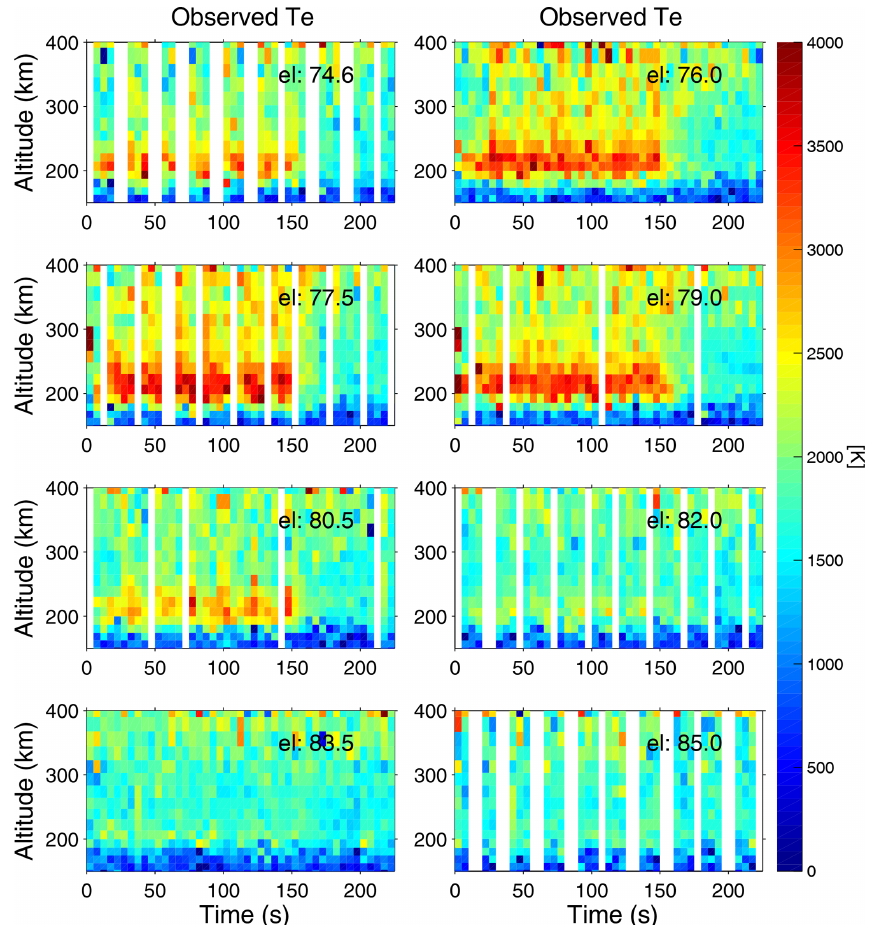
Figure 3. Height profiles of (cid:101) T e (colour coded) versus time for the different elevation angles of the UHF radar between 74.56 and 85.06 ◦ on 24 October 2017 (12:00:00–12:43:00UT). Pump-on was from t = 0 to t =